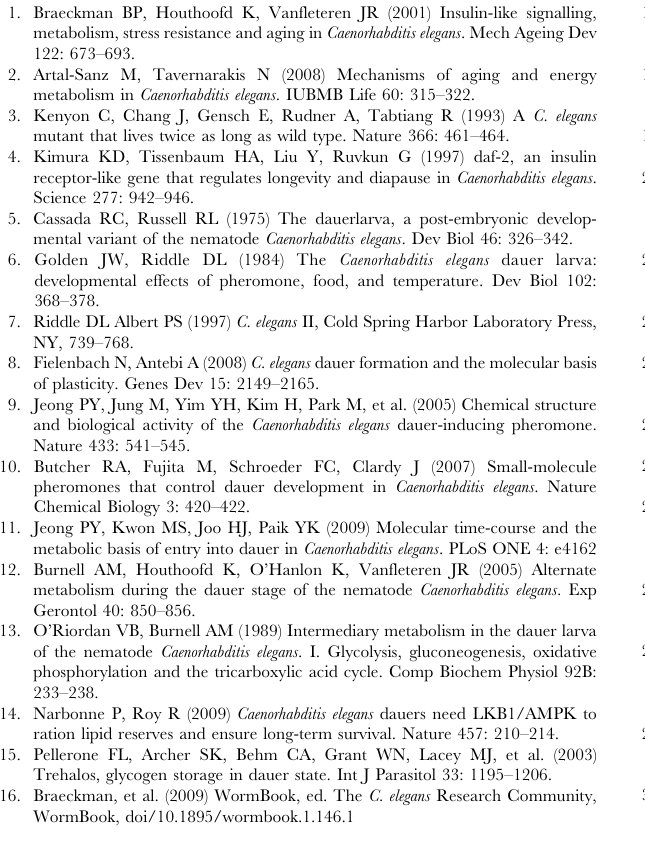
Figure S1 Structure of the pdhk-2 gene. The pdhk-2 gene (indicated by the black box) is located on chromosome III in C.